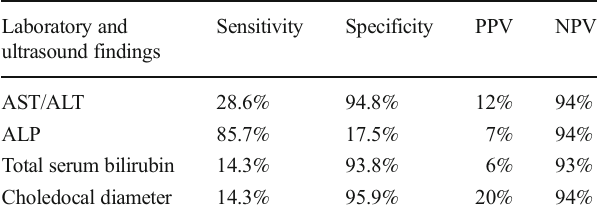
Sensitivity, specificity, positive and negative predictive values (PPVs and NPVs, respectively) of laboratory findings and choledocal diameter on preoperative US